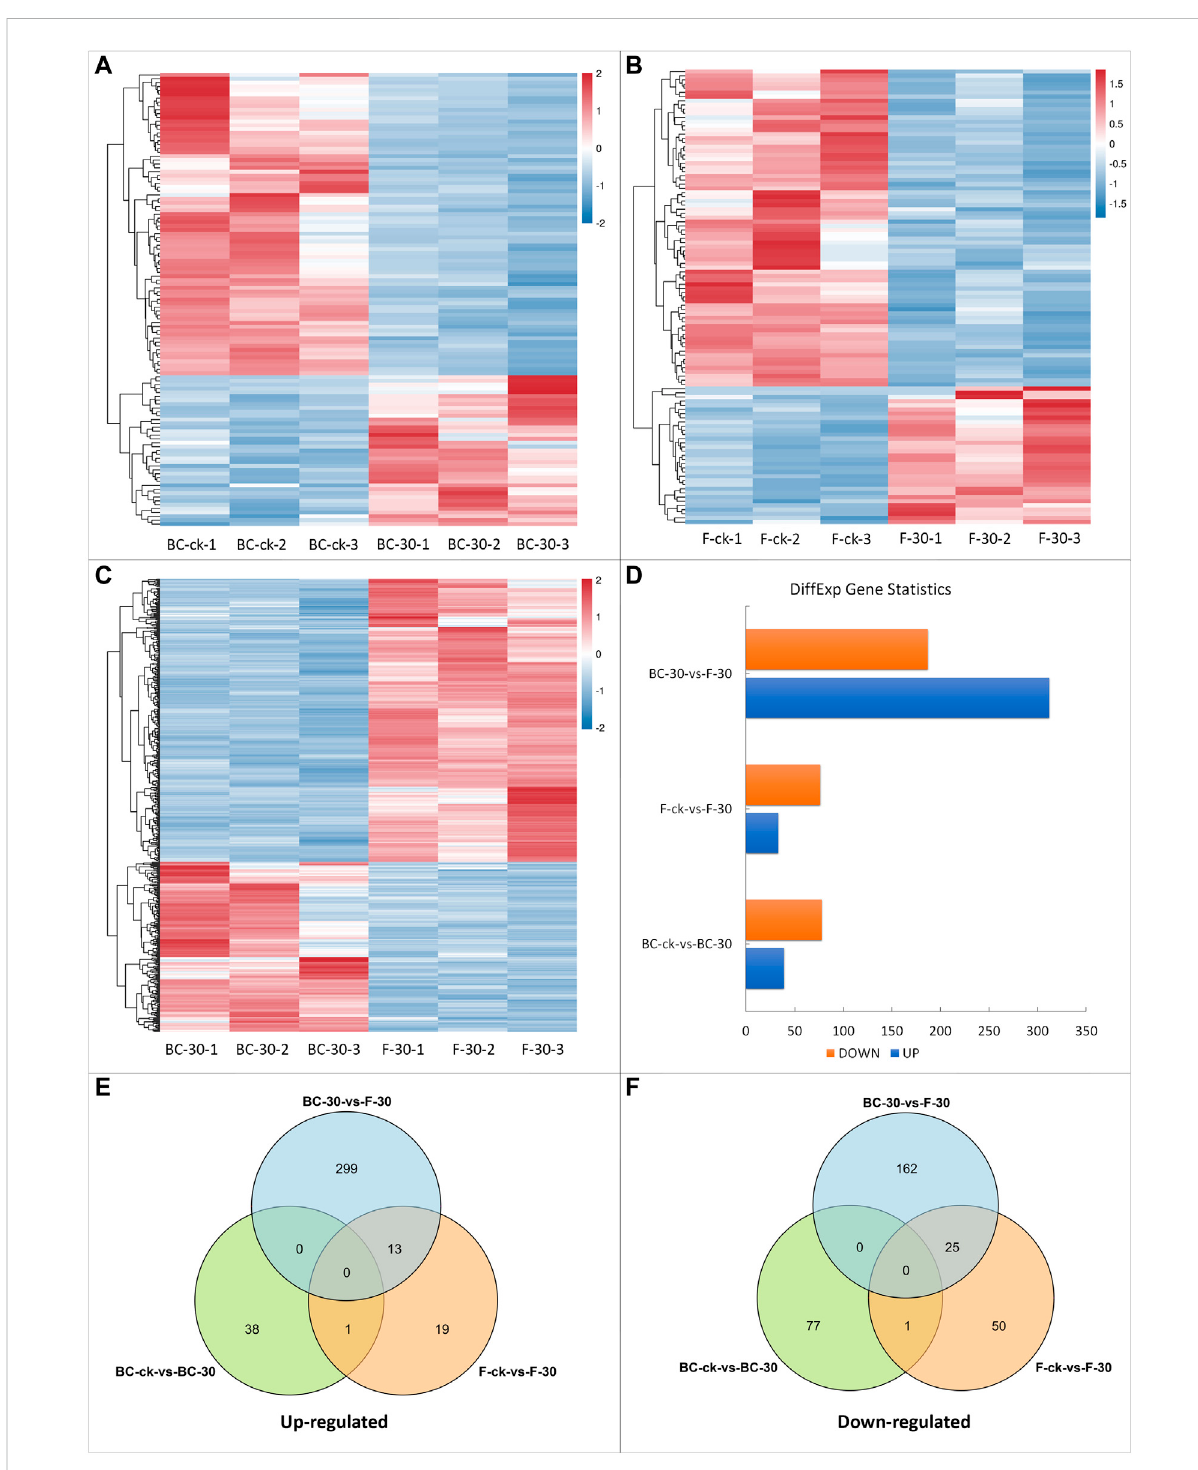
FIGURE 2 DEGs in response to insecticide treatments. (A) DEGs of BC-ck vs. BC-30, (B) DEGs of F-ck vs. F-30, (C) DEGs of BC-30 vs. F-30, (D) up- and downregulated genes among DEGs, (E) Venn diagram of upregulated DEGs from all treatments, and (F) Venn diagram of downregulated